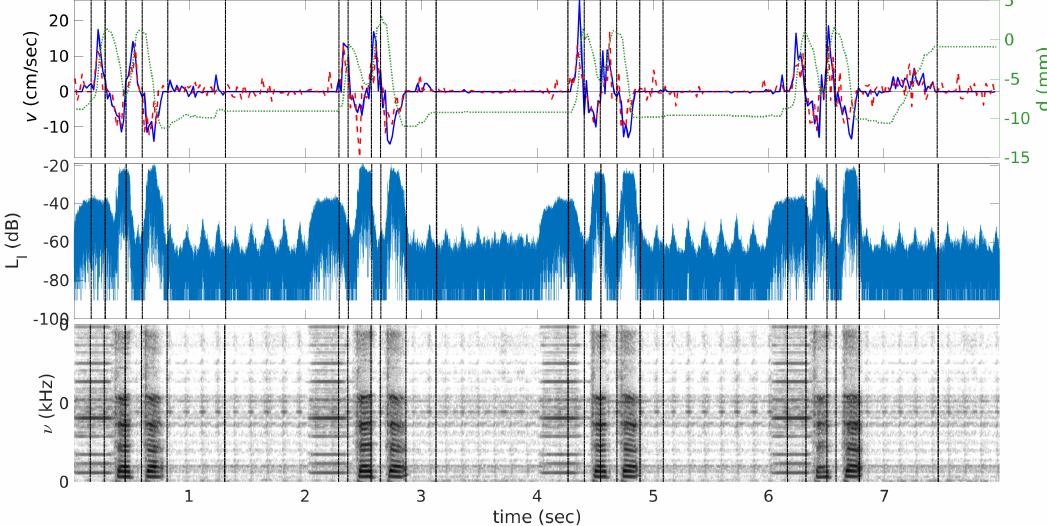
Figure 3. Velocity v (time) (the left scale) and displacement curves d (time) (the right scale) are shown on the top , sound level L I (time) (middle) and sound spectrogram s (time, ν ) (bottom) extracted from the real-time MRI images of the subject S2 and corresponding sound recordings. The solid curve corresponds to velocities evaluated manually, the dashed curve corresponds to those evaluated automatically, and the dotted curve corresponds to the displacement between the lower boundary of the slice used for the phase-contrast sequences and the tongue tip. Positive velocity values correspond to closure of the mouth and negative to opening. Vertical dash-pointed lines denote time when velocity takes zero